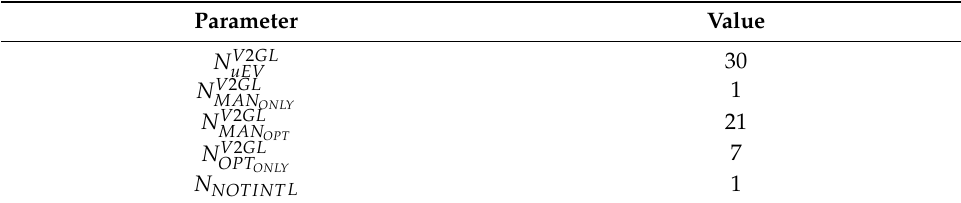
Table 6. Parameters required to calculate SUR